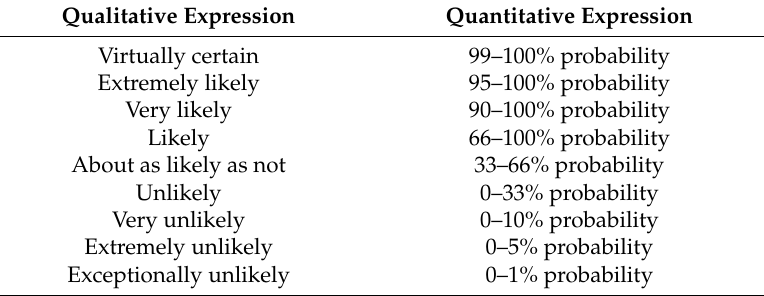
Table 2. Science is characterised by the quantitative expression of likelihood. Yet, deductive reasoning is essentially qualitative. This table—used by the Intergovernmental Panel on Climate Change (IPCC) [43]—is a useful bridge between the qualitative and quantitative (Section